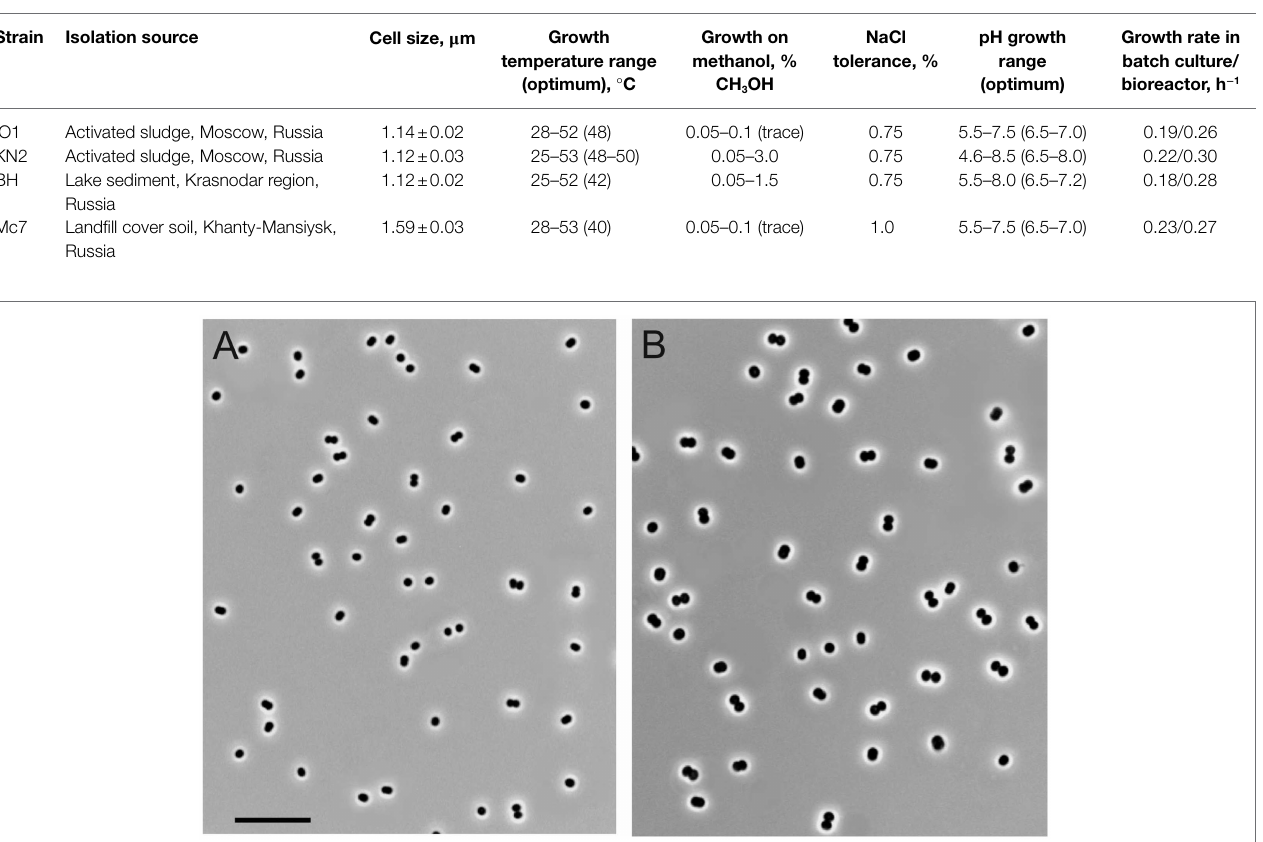
TABLE 1 | Isolation sources and some characteristics of new Methylococcus isolates.